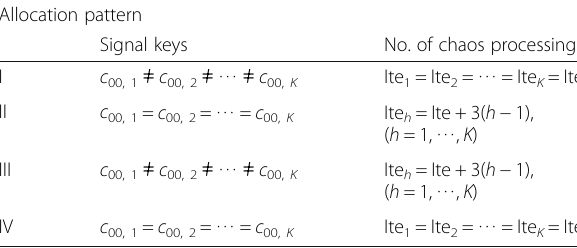
Table 3 Allocation pattern of signal key and chaos processing number Allocation pattern Signal keys No. of chaos